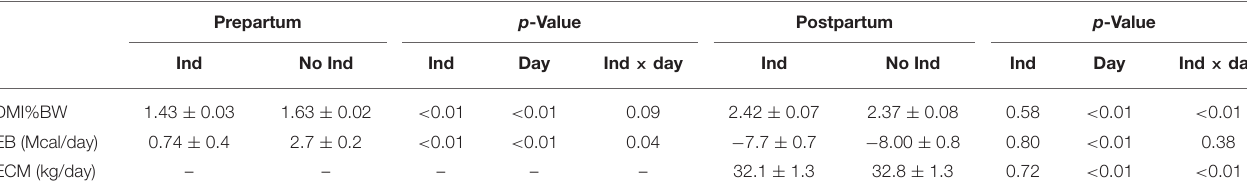
TABLE 4 | Association of pre- ( − 21 to − 1 days) and postpartum (1 to 28 days) dry matter intake as percentage of body weight (DMI%BW), energy balance (EB), and energy-corrected milk (ECM) with indigestion (Ind) postpartum according to multivariable